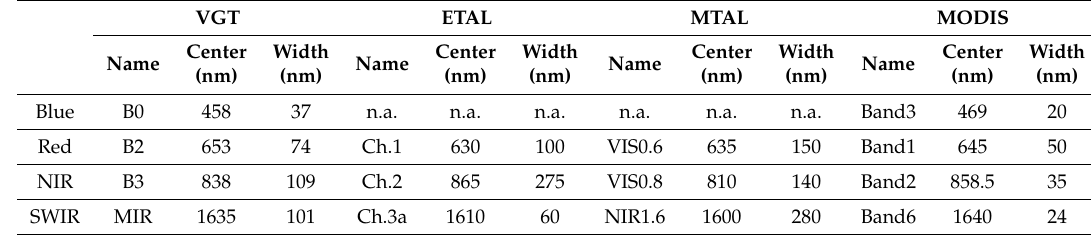
Table 1. Spectral characteristics of VGT, ETAL, MTAL and